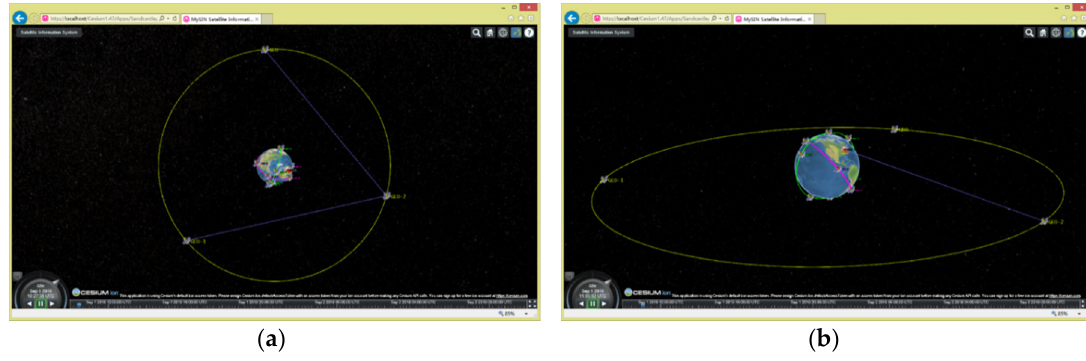
Figure 14. The 3D view display of the GEO satellite information system: ( a ) The connections between the GEO satellites; ( b ) the data transmission status of GEO-2 and the ground station.